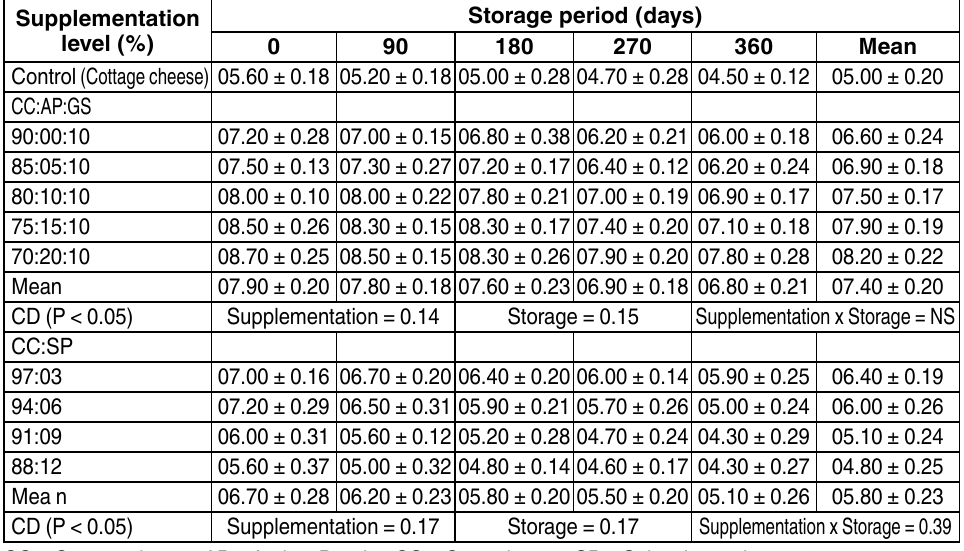
Table 4. Effect of supplementation and storage on flavour of value-added churpe products (balls and strips) Supplementation level